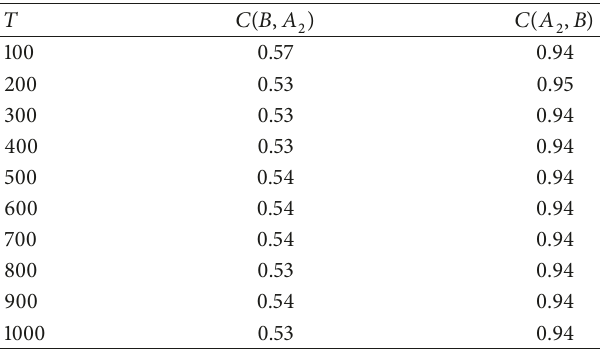
Table 2: 𝐶 -metric every hundred generations by proposed method with 𝑑 = 0.025 (algorithm 𝐴 2 ) and NSGA-II (algorithm 𝐵 ).